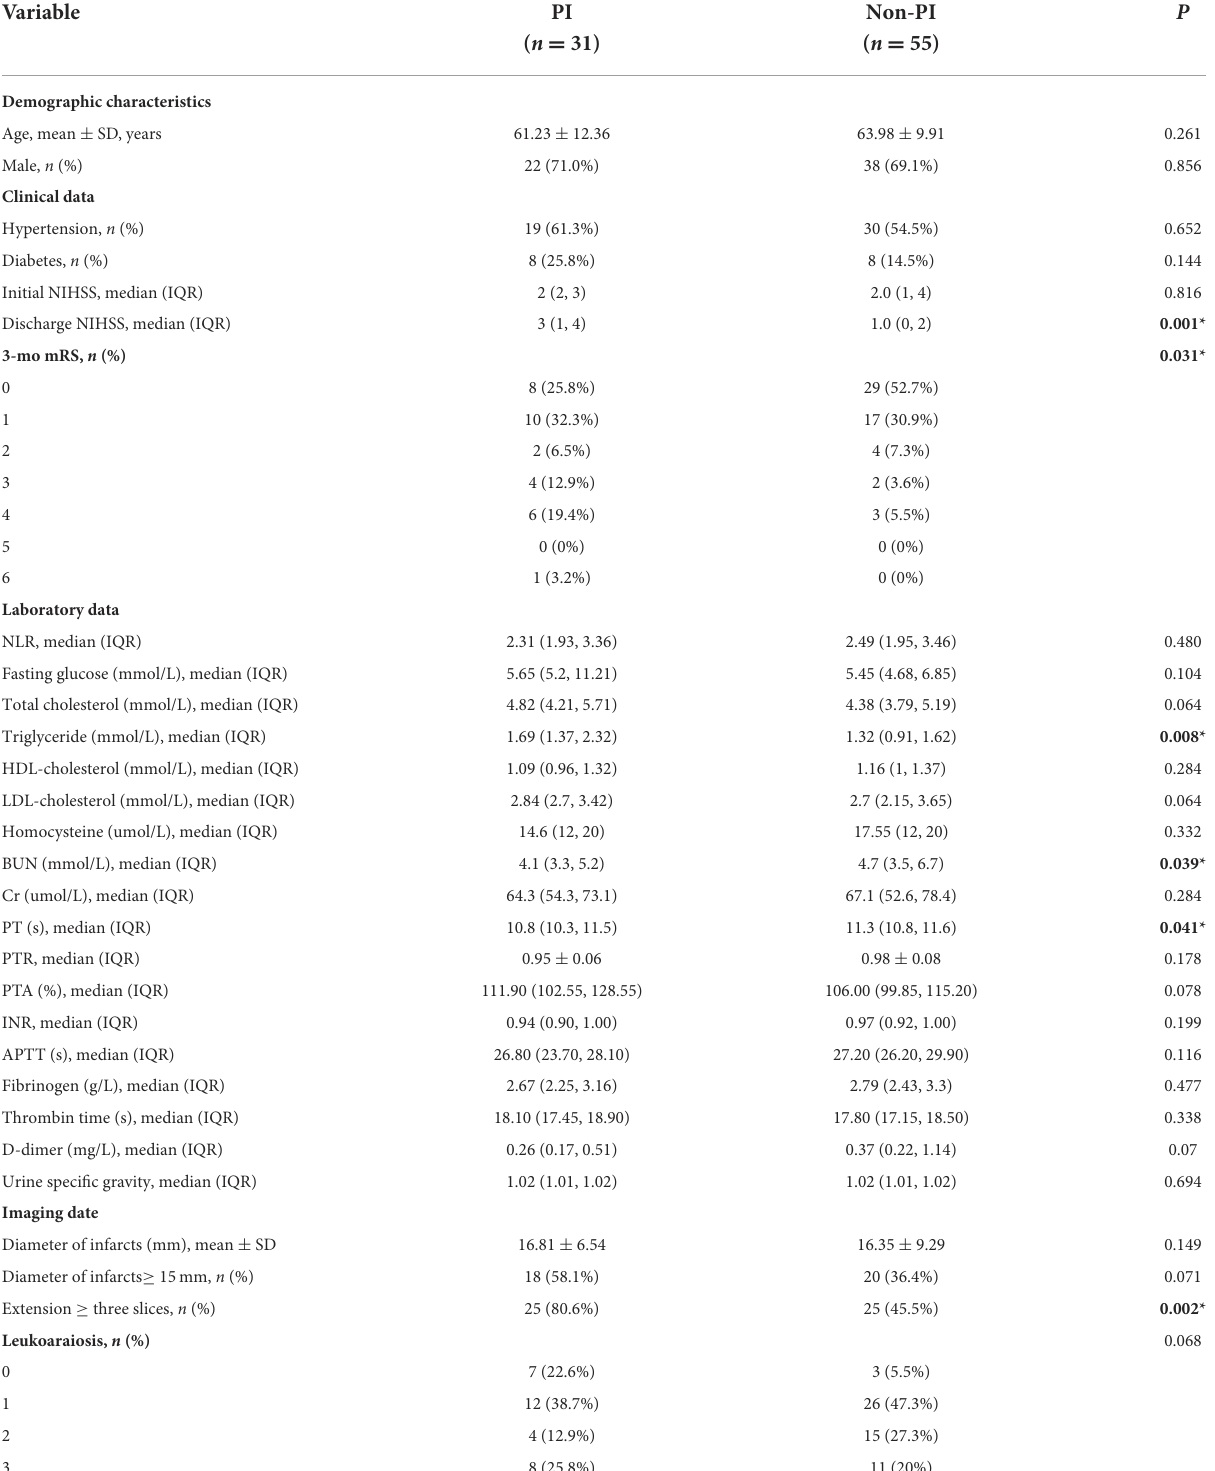
TABLE 1 Comparison of baseline characteristics between PI and non-PI groups.